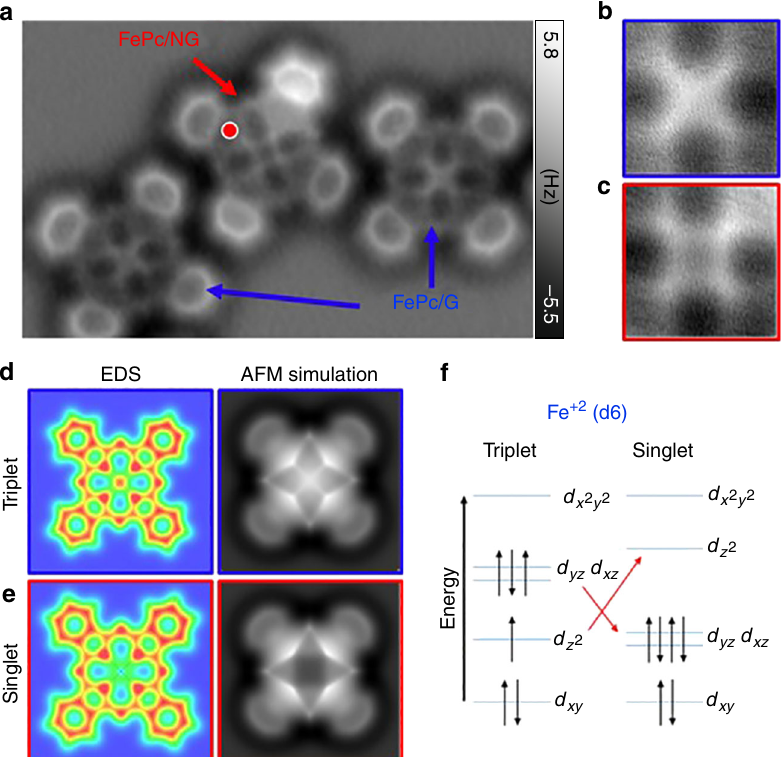
Fig. 4 Spin crossover on a FePc molecule. a Constant-height AFM image of three FePc molecules located on pure graphene (blue arrows) and above an N- dopant (red arrow). The red dot marks the exact position of the N-dopant. b and c AFM images of the cross and square features at the core of a FePc molecule on pristine and N-doped graphene, respectively. d and e Calculated electron density and simulated AFM image of FePc when the Fe atom is in the triplet and singlet spin state, respectively. In the triplet state, a cross-shaped feature was observed at the core of FePc, whereas a square feature was obtained in the singlet state due to electron depletion at the center of the molecule. f Occupation of Fe + 2 orbitals in the triplet and singlet states. (Note: the other triplet state characterized by the iron d -orbital occupation d xy 2 d z 2 2 d xz 1 d yz 1 d x 2 - y 2 0 provides the same scenario). Since, d z 2 , d xz , and d yz orbitals are